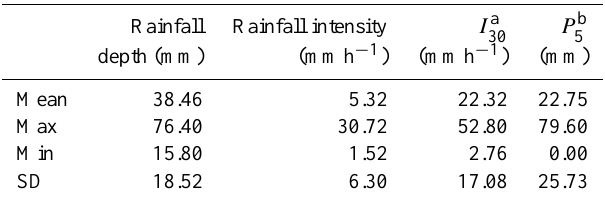
Table 3. Statistical characteristics of rainfall for the simulated runoff